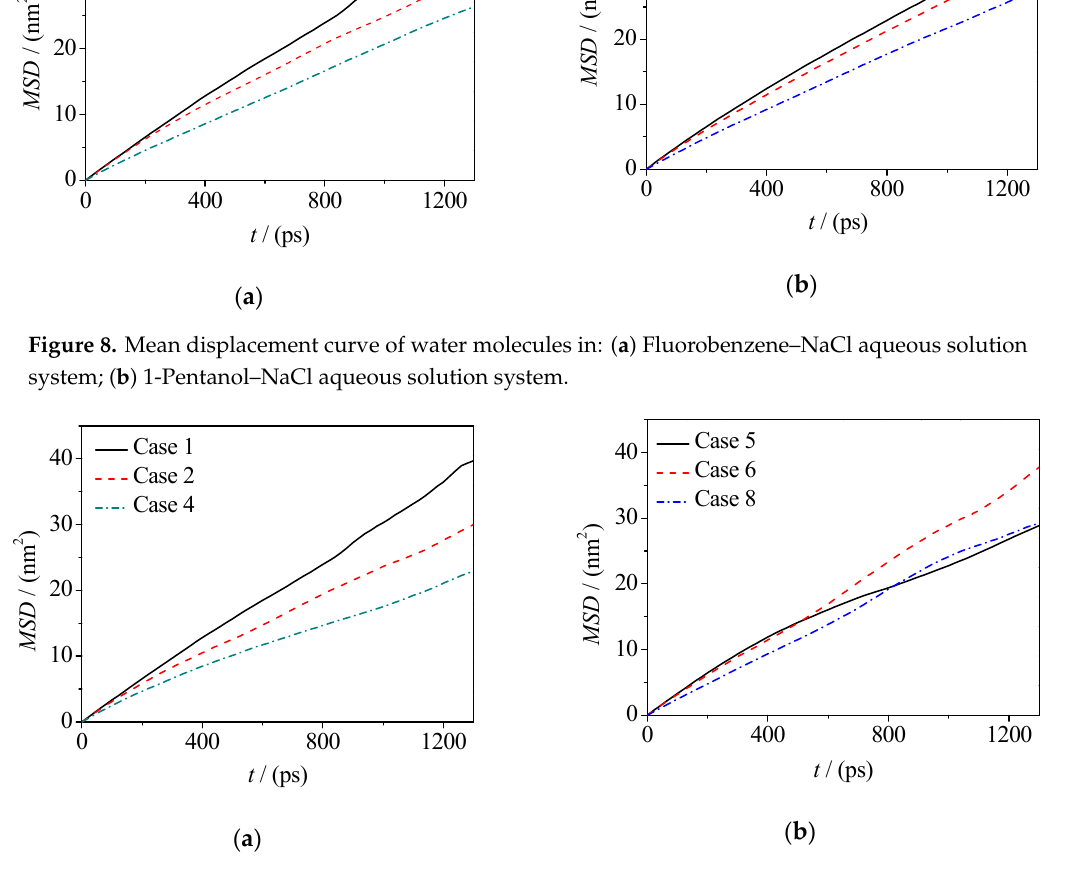
Figure 9. Mean displacement curve of water molecules at the interface: ( a ) Fluorobenzene–NaCl aqueous solution system; ( b ) 1-Pentanol–NaCl aqueous solution system. Table 2. Diffusion coefficients (in three-dimensional space) of water molecules in the water phase and at the interface with different oil–water interface systems (unit: 10 − 10 m 2 /s).